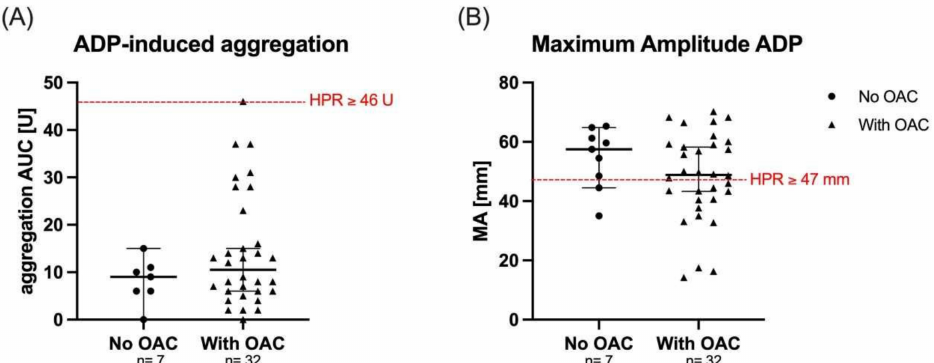
Figure 2. Platelet reactivity according to oral anticoagulation. Aggregation values for ADP-induced aggregation as assessed by MEA ( A ) and MA ADP as assessed by TEG ( B ) with and without OAC therapy. Red line represents HPR cut-off and black line median with interquartile